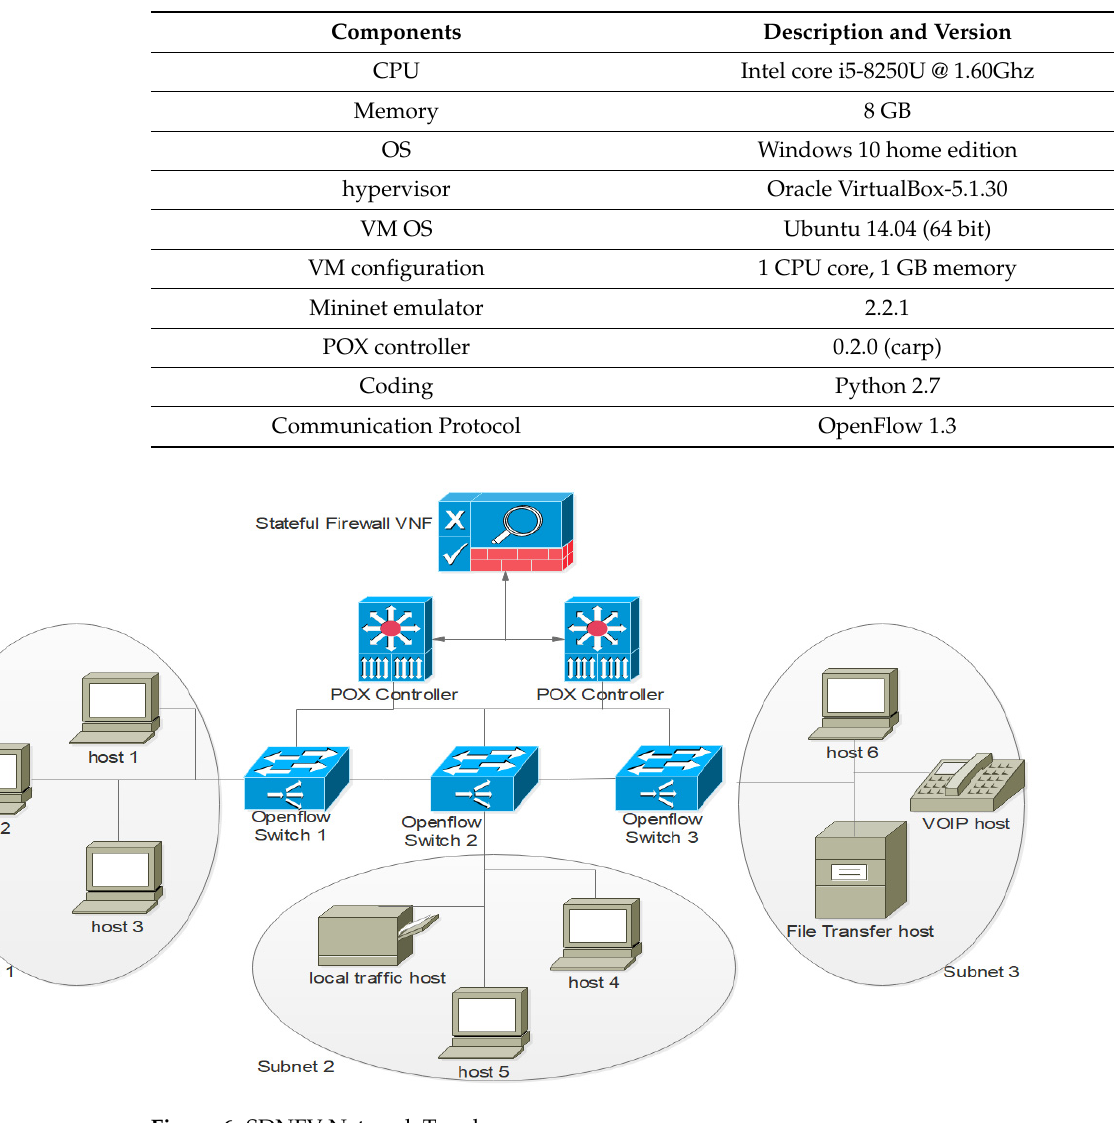
Figure 7. Flow of proposed SDNFV Network. 5. Results and Discussion A Spyder machine learning tool is used to assess the accuracy of the used ML models. Honeypot attack data from “AWS” was used for training purposes. The honeypot from Amazon web services was a trap spot that can be integrated into the system to identify incoming attempts from data pullers and malicious bots. If a source accesses the honeypot, the IP addresses will be registered. AWS honeypot attack dataset also includes analysis of